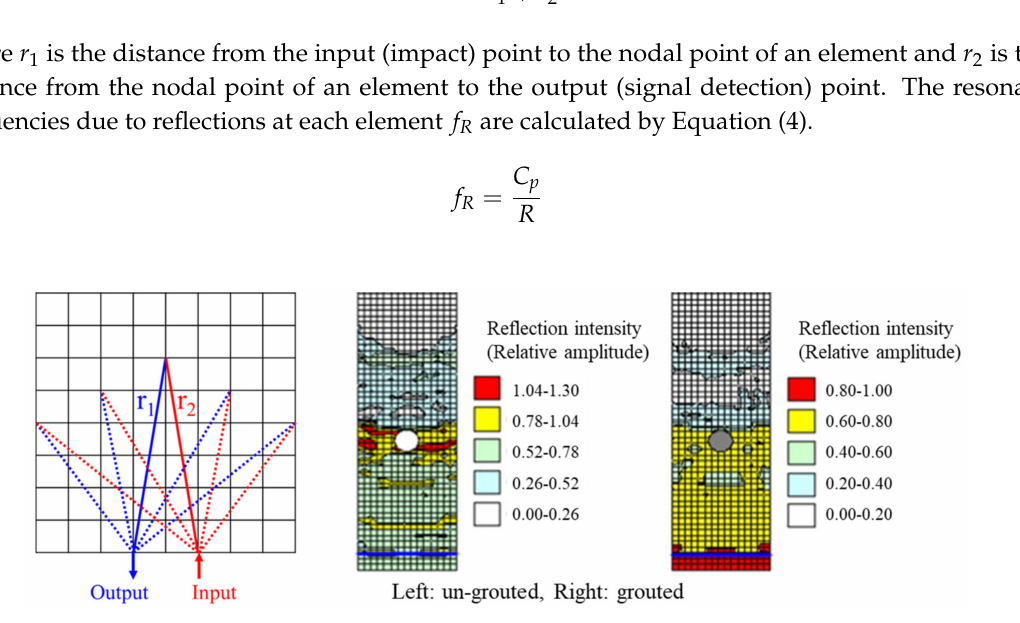
Figure 2. Mesh division and results of SIBIE (Stack Imaging of spectral amplitudes Based on Impact-Echo) procedure